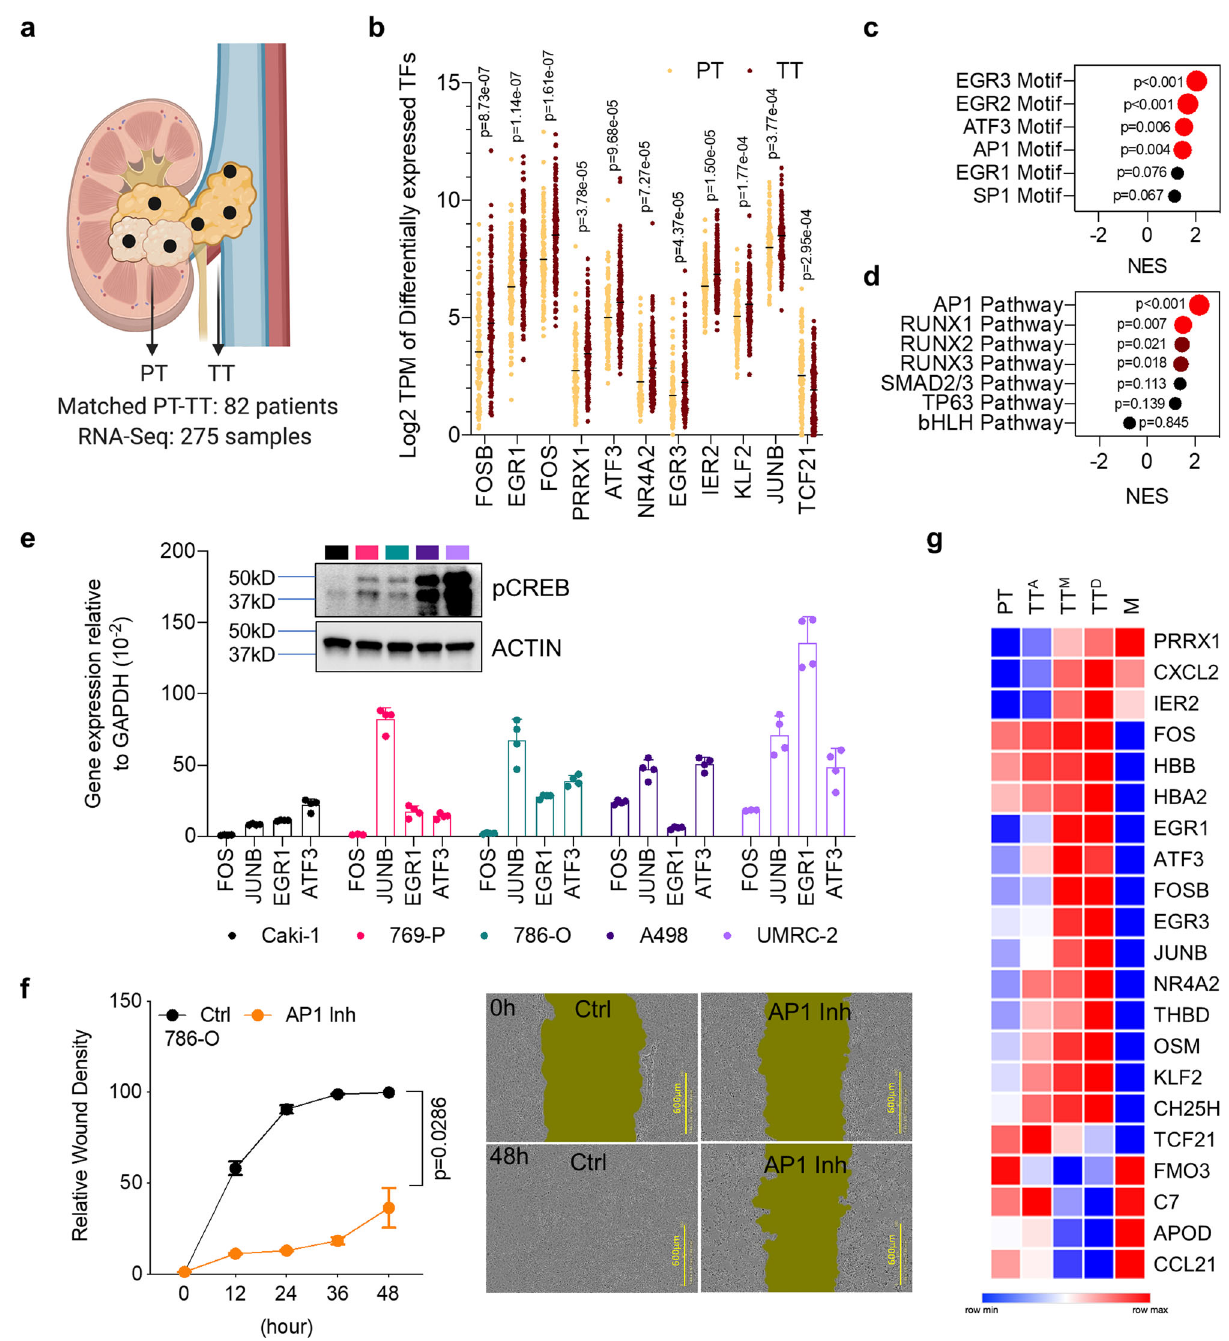
Fig. 3 Invasion driven by immediate early genes represents a reversible adaptive response. a Illustration highlighting paired PT and TT samples used for transcriptomic analysis. b Differentially expressed transcription factors from biologically independent PT ( n = 114) and TT ( n = 161) patient tumor samples. Data are presented as scatter dot plots with lines at mean. Two-sided unpaired Student t test. c , d Motif enrichment ( c ) and signaling pathways ( d ) based on transcriptomic data from invasive TT. Nominal p -value from GSEA analysis <0.05 (brown color); <0.01 (red color). e qRT-PCR results showing expression of immediate early-response genes in ccRCC cell lines ( n = 4 biologically independent samples). Data are presented as mean values ±SD. Western blot showing phospho-CREB status in ccRCC cell lines (inset). Source data are provided as a Source Data fi le. f Scratch wound healing assay of 786 ccRCC cells in the presence of AP-1 inhibitor T-5224 as indicated ( n = 4 biologically independent samples). Data are mean values ±SEM. Two-tailed Mann – Whitney U -test. g Heat map showing changes in gene expression in PT, TT, and metastasis